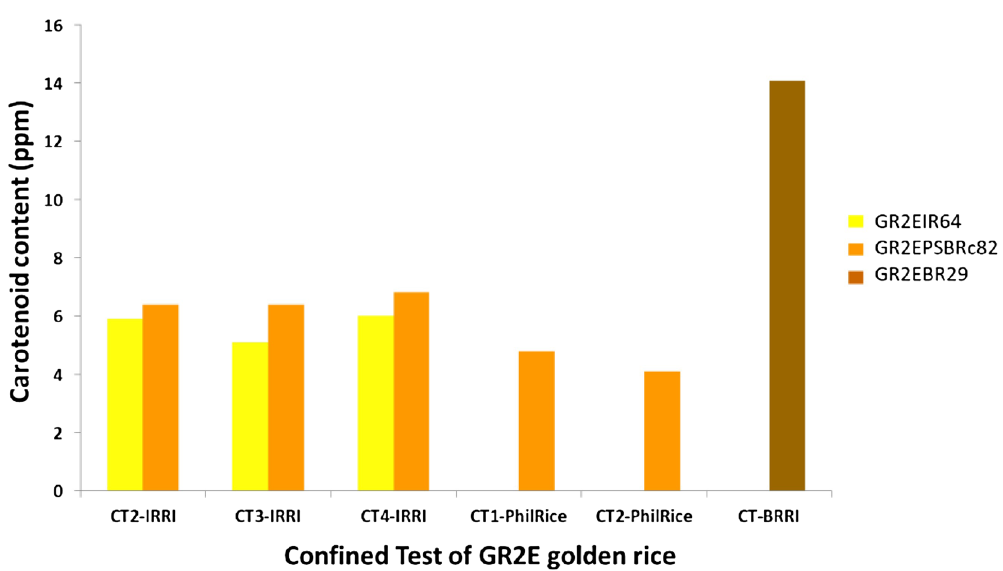
Figure 3. Carotenoid levels in different genetic